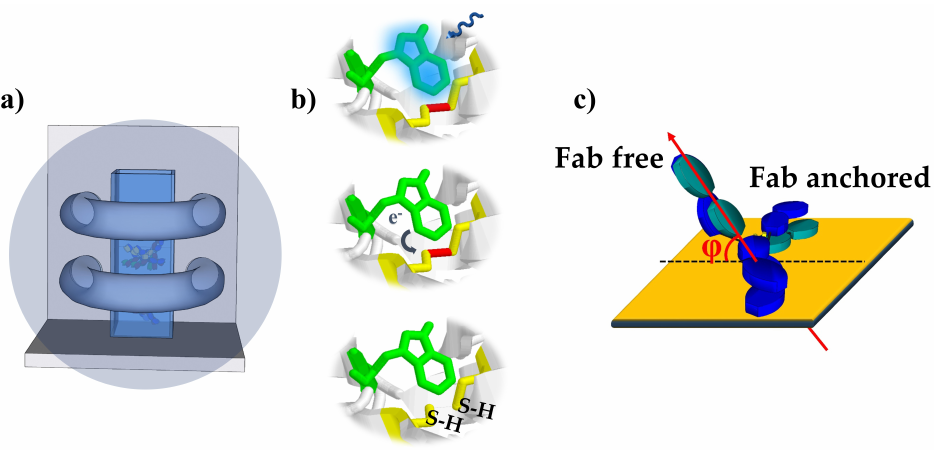
Figure 2. ( a ) UV lamp used for the UV activation of the antibodies. Emitting wavelength: 254 nm, diameter of each lamp: 1.5 cm, dimensions internal: space 1 cm × 1 cm × 4 cm, power of each lamp 6 W, irradiation intensity 0.3 W / cm 2 ; ( b ) Description of the reaction involved in PIT: the UV photon